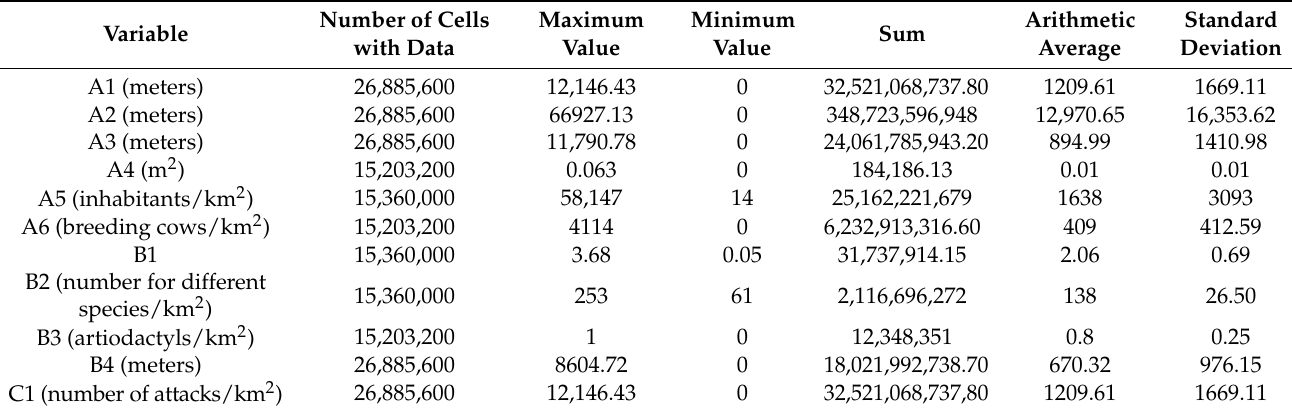
Table 1. Summary of the basic statistics obtained in the processing of each